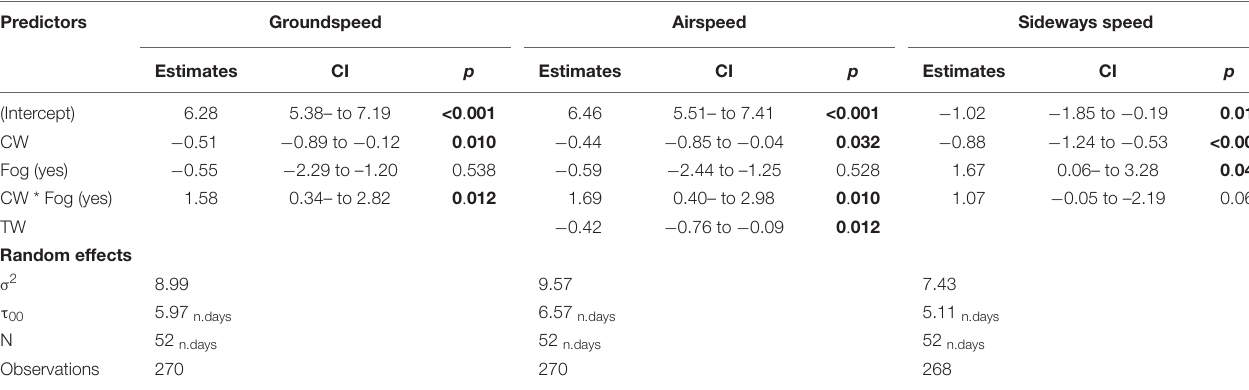
TABLE 1 | The selected linear mixed models reporting the effects of wind and fog on bird average hourly